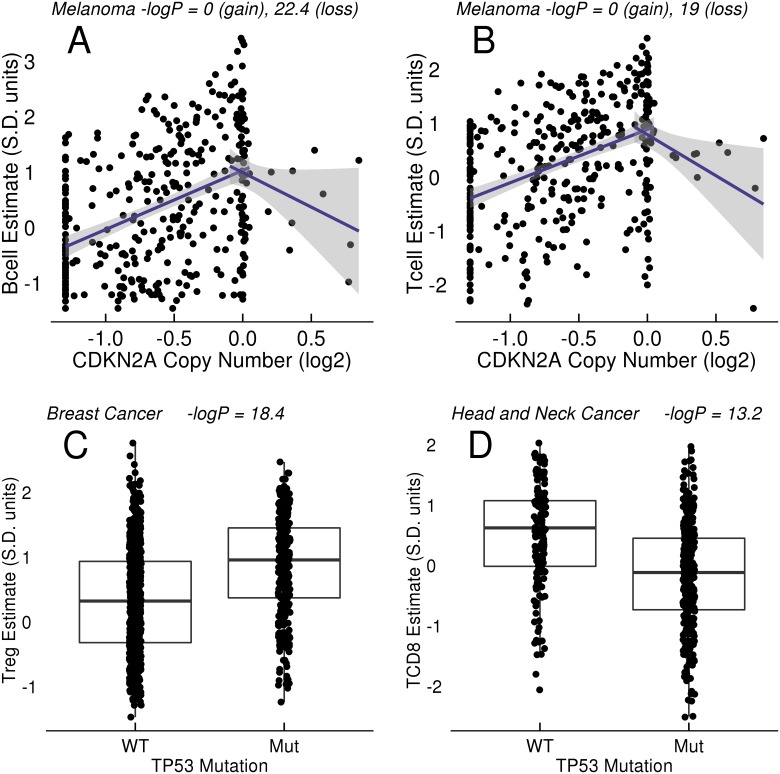
Association of CDKN2A CNA and TP53 mutation with immune estimates in tumors.(A-B) Relationship of CDKN2A copy number estimates to B and T cell estimates across TCGA melanoma. The horizontal scale is the log2 GISTIC CNA estimate (0 = diploid, -1.3 = homozygous loss). The signature scores are measured in units of standard deviation of the signature's variation across TCGA tumors. Independent tests of association were performed for CNA > -0.1 and CNA < 0.1. The lines drawn are the linear regressions of the gain/loss CNA with the immune estimate, with shading to indicate the 95% confidence interval around the line's slope (without model covariate adjustments or multiple test corrections). (C) Relationship of TP53 mutation to regulatory T cell (Treg) estimates across breast cancer. (D) Relationship of TP53 mutation to CD8+ Tcell estimates in head and neck cancer.